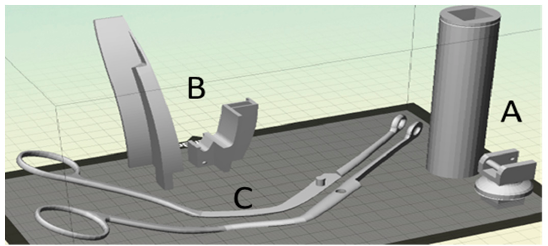
Figure 5. Three-dimensional models for printing representing the (A) laryngoscope, (B) Macintosh blade (size 4), and (C) Magill forceps [12].